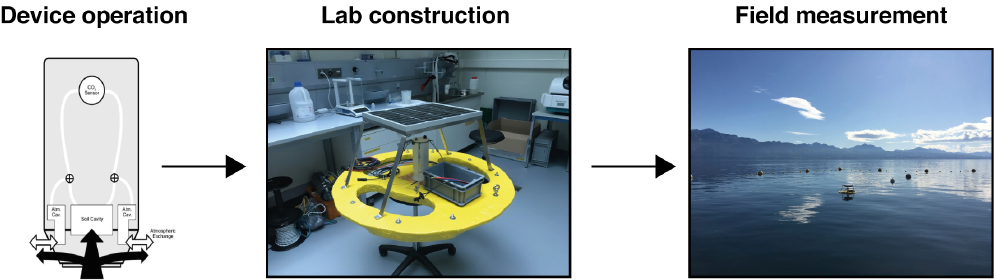
Figure A1. Schematics of eosFD operation (https://eosense.com, last access: 18 August 2020), its mini-platform construction, and its po- sitioning for measurements in the field (Lake Geneva at LéXPLORE platform). The raft design also complies with recommendations to minimise artificial turbulence induced by the chamber’s walls, with 10cm long-edges entering the water (Vachon et al., 2010).